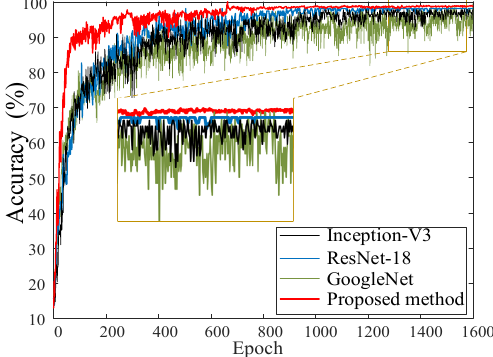
Figure 14. The accuracy convergence curves of different diagnostic methods.